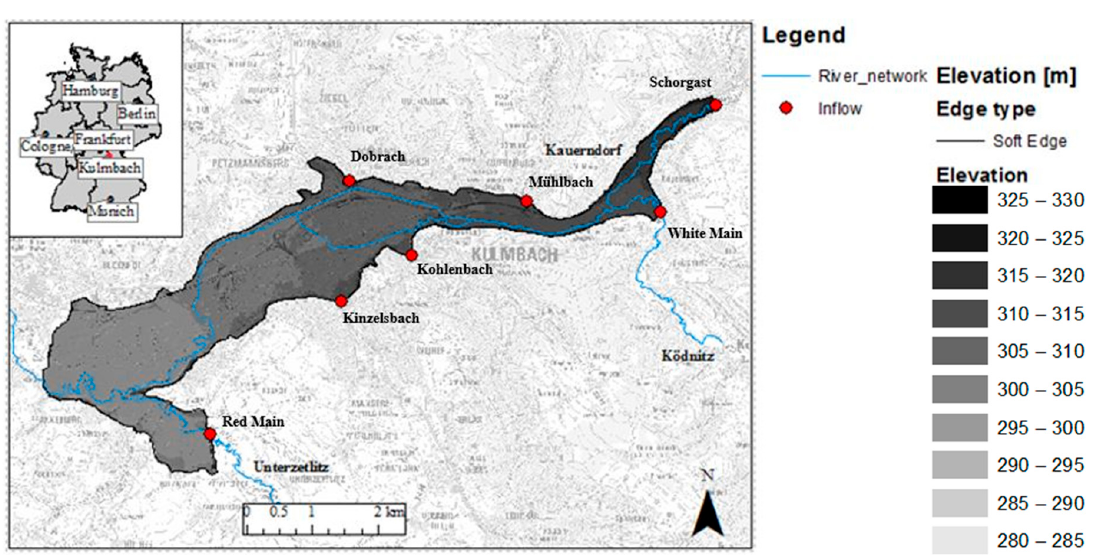
Figure 4. Map of the study area. It shows the location of Kulmbach in Germany. The blue curves represent the river network. The shaded region is the study area with its topography represented. On the marked boundary, the red points represent the seven inflows on the boundary (three rivers and four smaller streams).